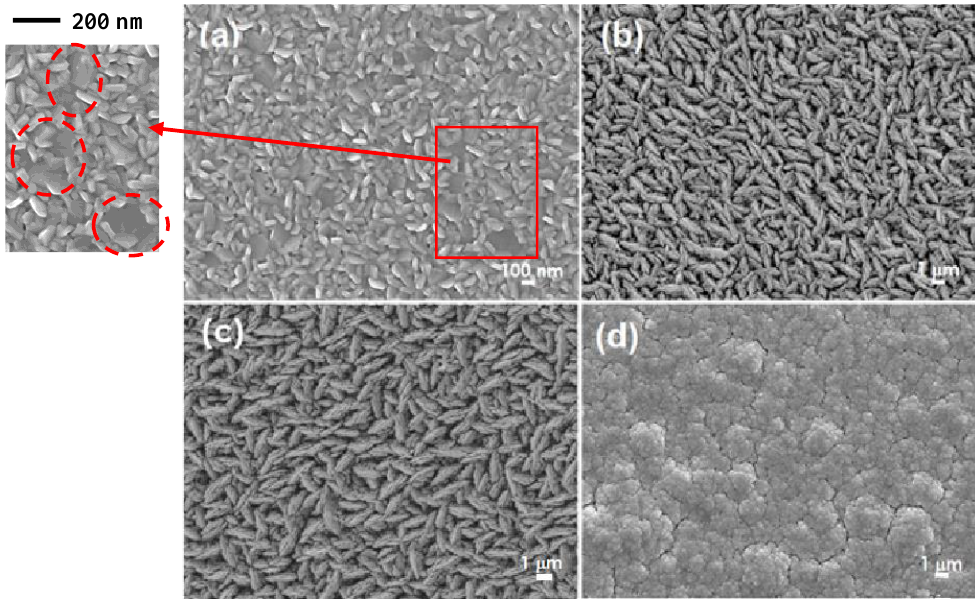
Figure 4. Surface morphology of annealed Sb 2 Te 3 films with different film thicknesses: ( a ) 0.3, ( b ) 4.5, ( c ) 9.0 and ( d ) 16.7 µm.